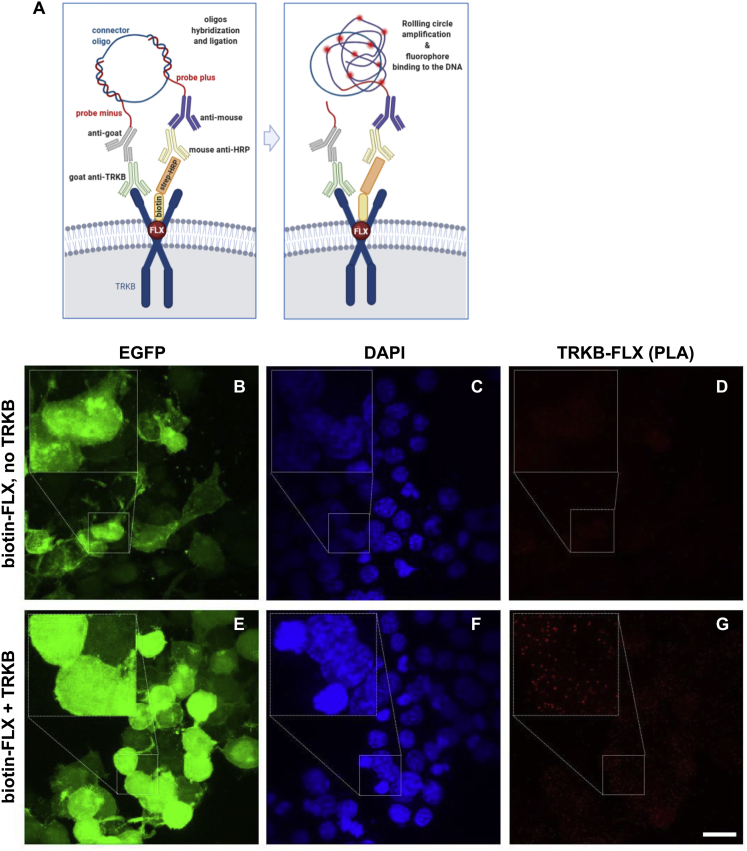
Antidepressants bind to TRKB in the intact cells, related to Figure 2(A) Schematic representation of the in situ proximity ligation assay (PLA) between TRKB and biotinylated fluoxetine. (B-G) HEK cells were transfected to express TRKB and farnesylated GFP and were exposed to biotinylated fluoxetine (10uM/15min). The cells were fixed in PFA and the PLA reaction was conducted in permeabilized cells. (B-D) No signal from TRKB-FLX interaction was observed when cells were not transfected to express TRKB. (E-G) positive signal of TRKB-FLX (PLA). Scale bar: 20 μm. Zoom in square: 2.5x.